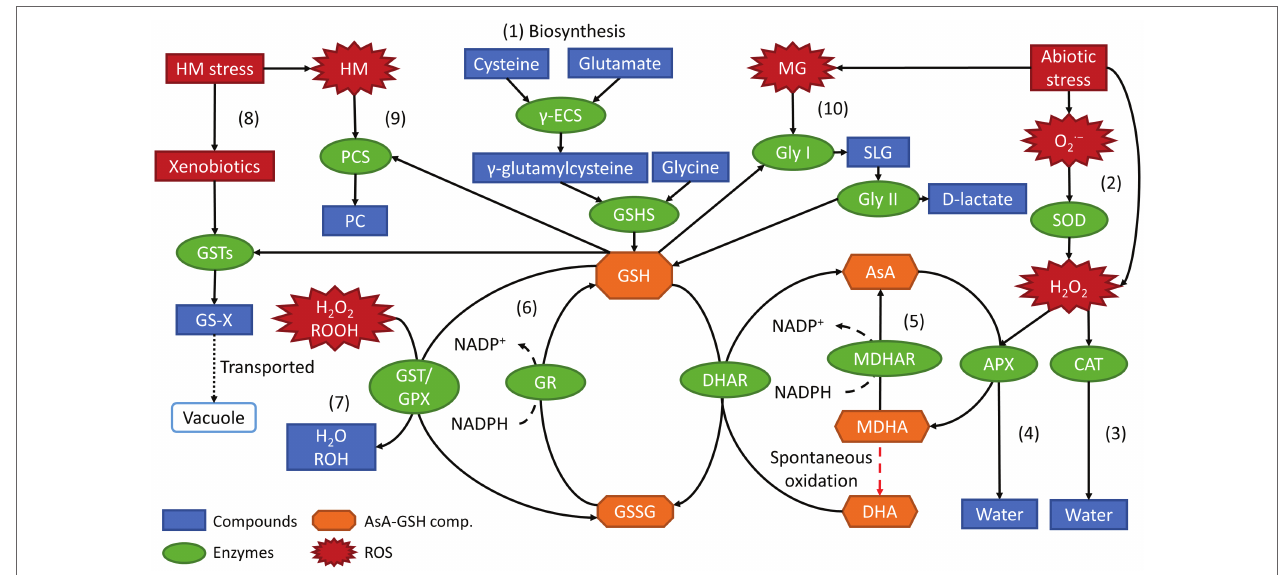
FIGURE 3 | Overview of biosynthesis and roles of GSH along with its metabolism-related enzymes in response to abiotic